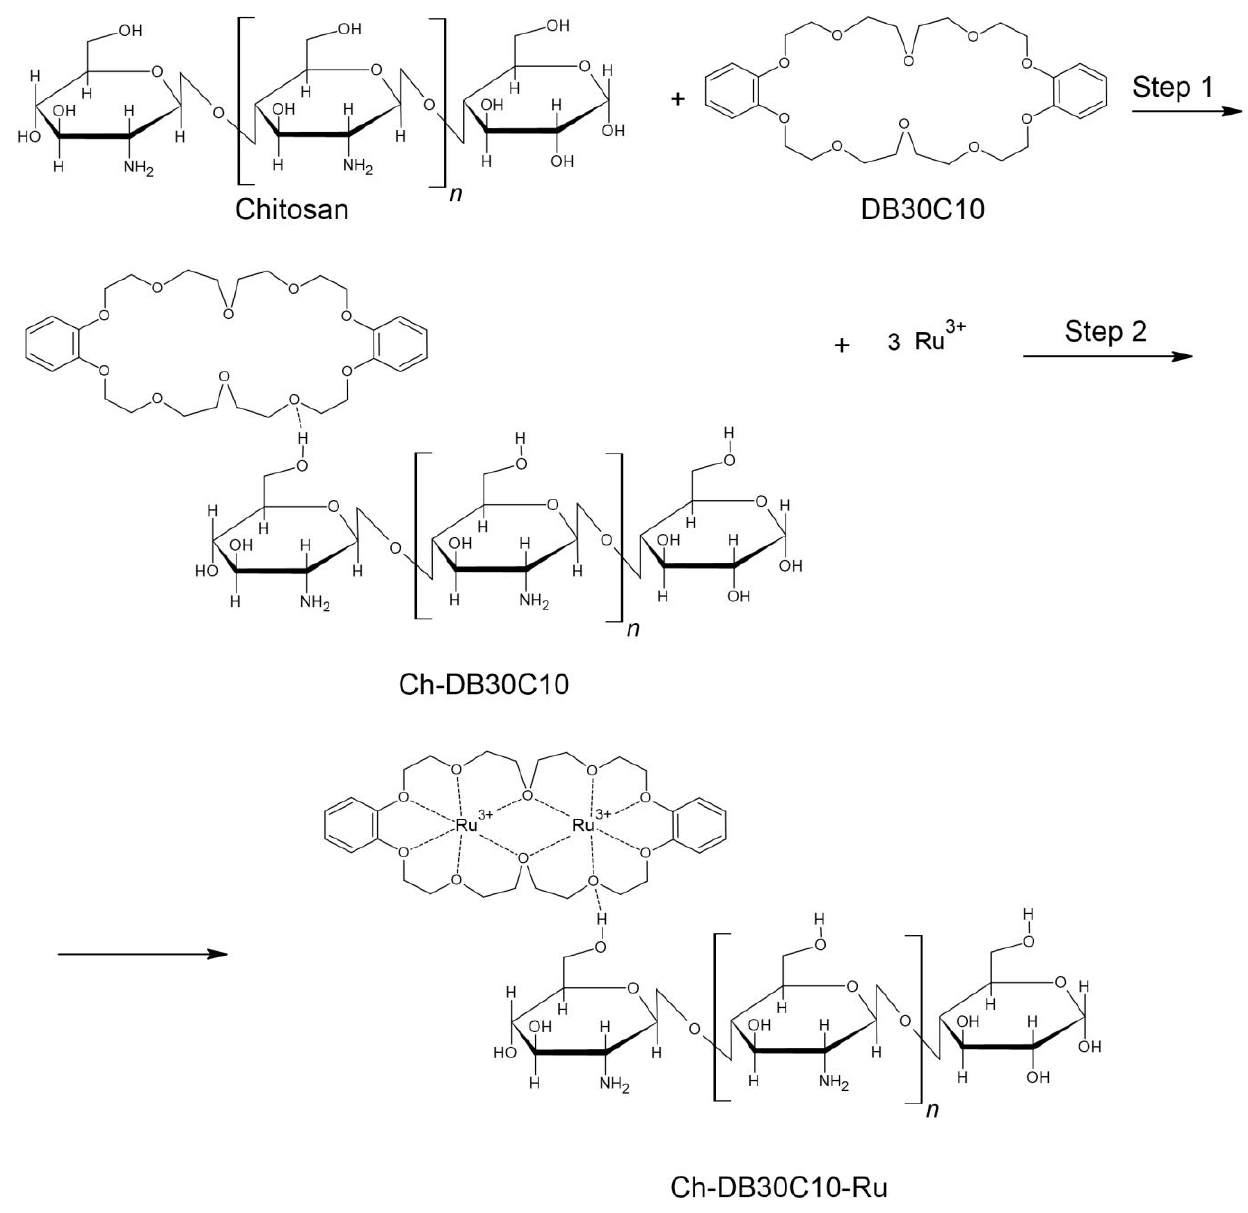
Figure 13. Mechanism for Ru(III) adsorption onto Ch-DB30C10.